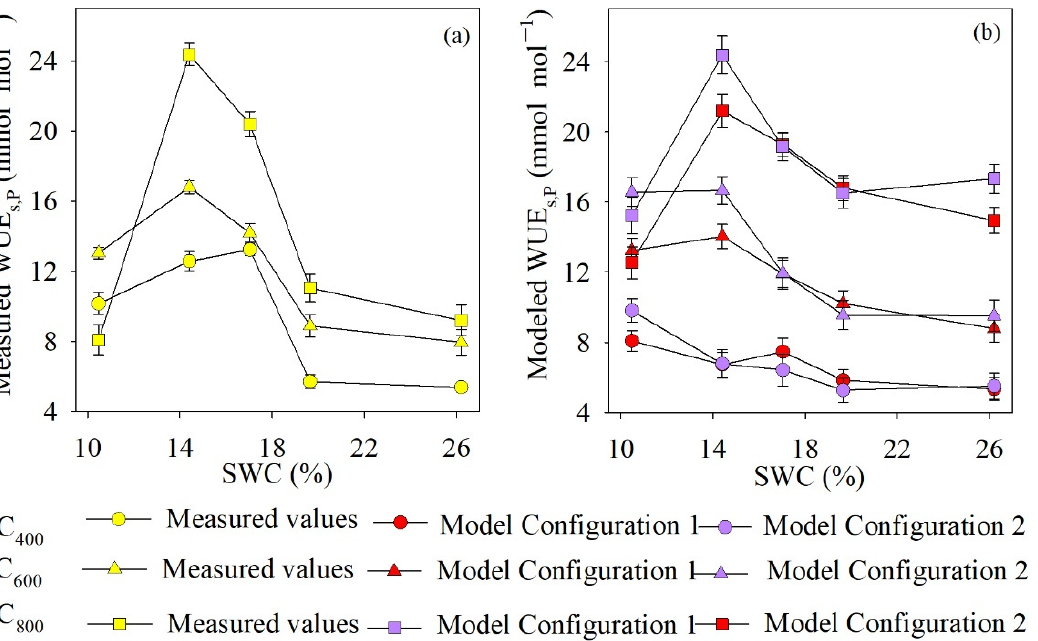
Figure 8. Measured ( a ) and modelled ( b ) whole-plant short-term water use efficiency (WUE s,P , mmol·mol − 1 ) under five soil water contents (SWC) × three CO 2 concentrations ( C a ) conditions. C 400 , C 600 , and C 800 are C a of 400, 600, and 800 μ mol·mol − 1 . Data represent mean values ± SD.